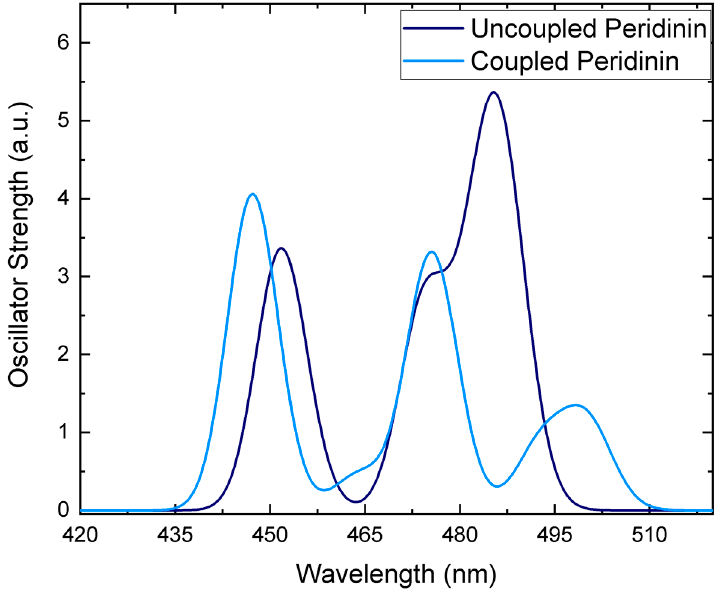
Figure 3. Simulated absorption spectra for the uncoupled (dark blue) and coupled (light blue) four Pers of a cofactor cluster in the solvated PCP complex. Gaussians with a full width at half maximum of 8 nm were fit to the calculated excitation wavelengths.